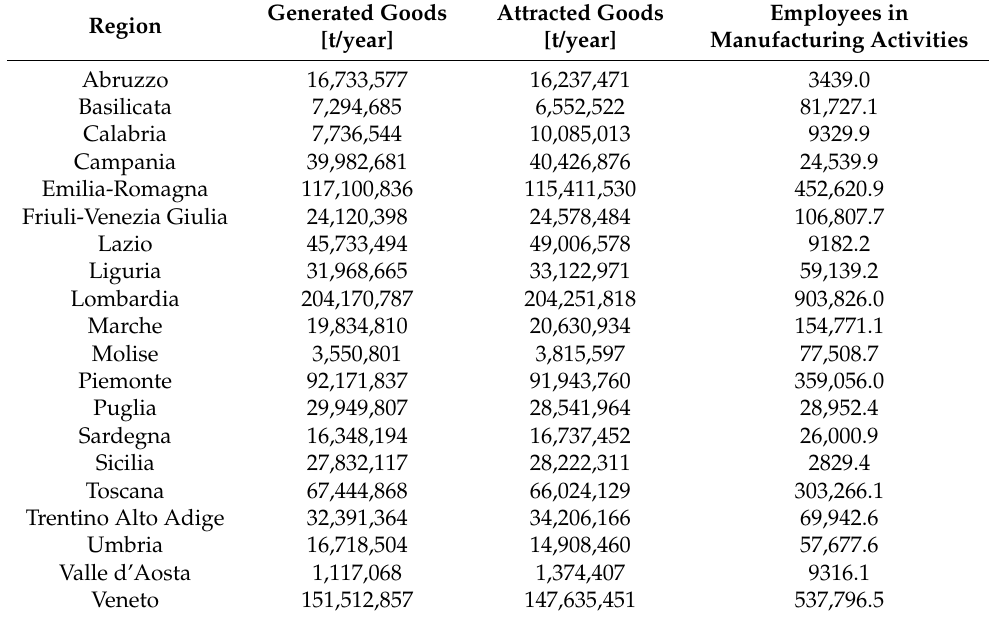
Table 1. Regional data elaborated from the ISTAT database [27,28]. Region